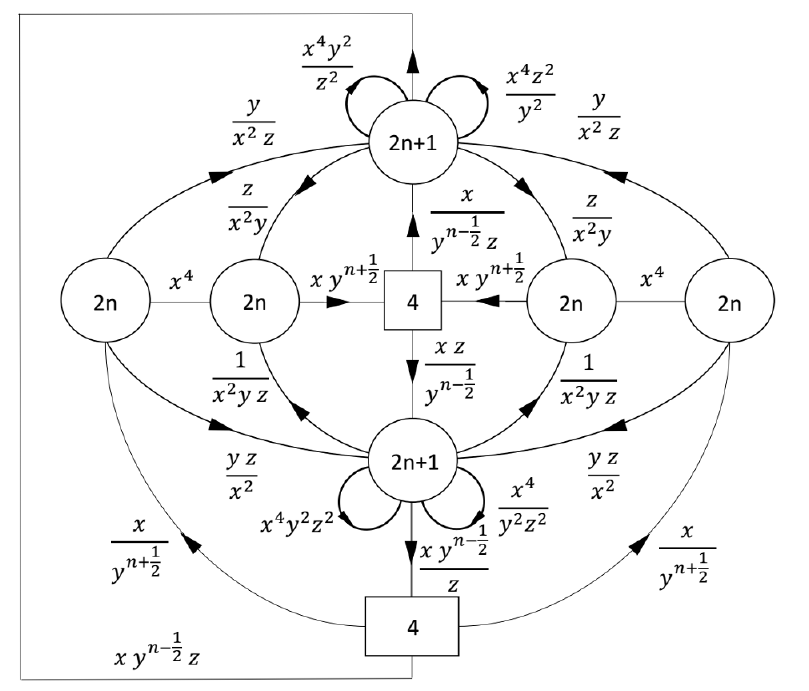
Figure 7 . The 4 d quiver theory associated to compacti(cid:12)cation and mass deformation, but now with (cid:13)ux 1. The 2 n groups are of type USp while the 2 n + 1 ones are of type